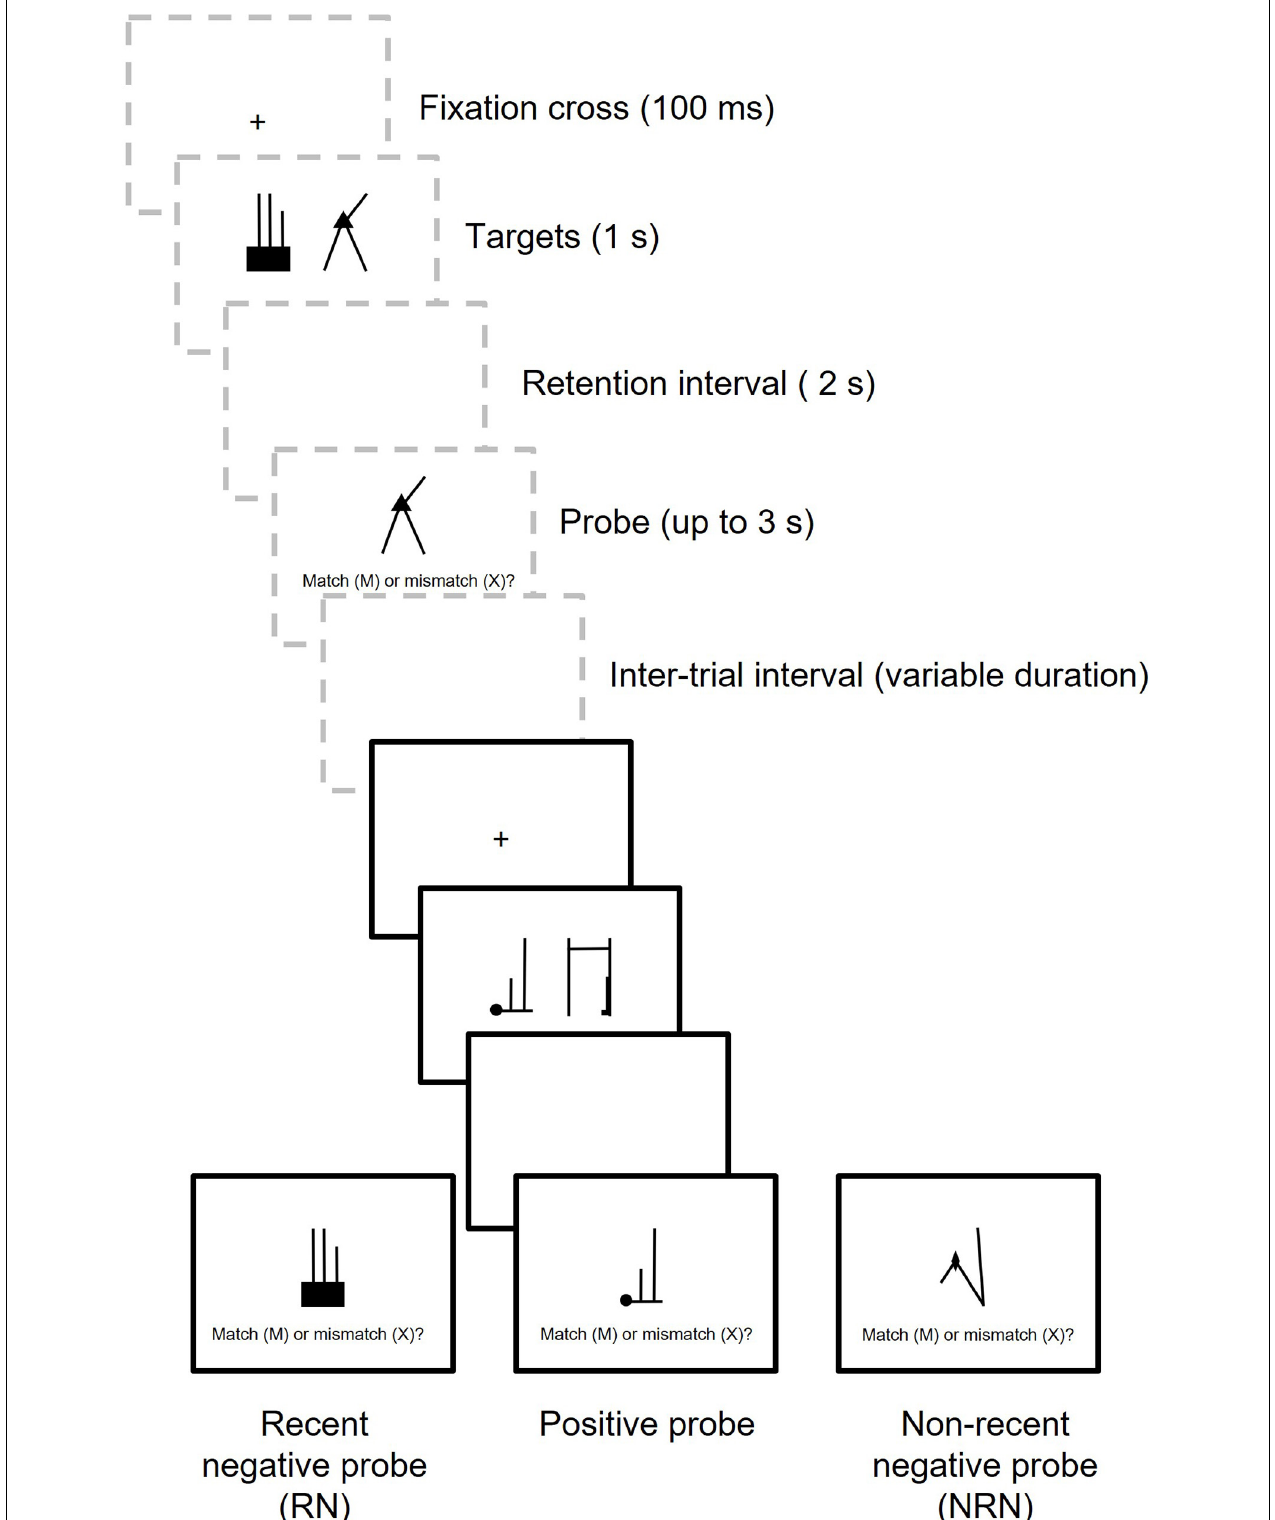
FIGURE 1 | Diagram showing two trials in the recent probes task. Trial N -1 is shown in dashed gray boxes and Trial N is shown in black boxes. In this example, two targets are encoded on each trial.